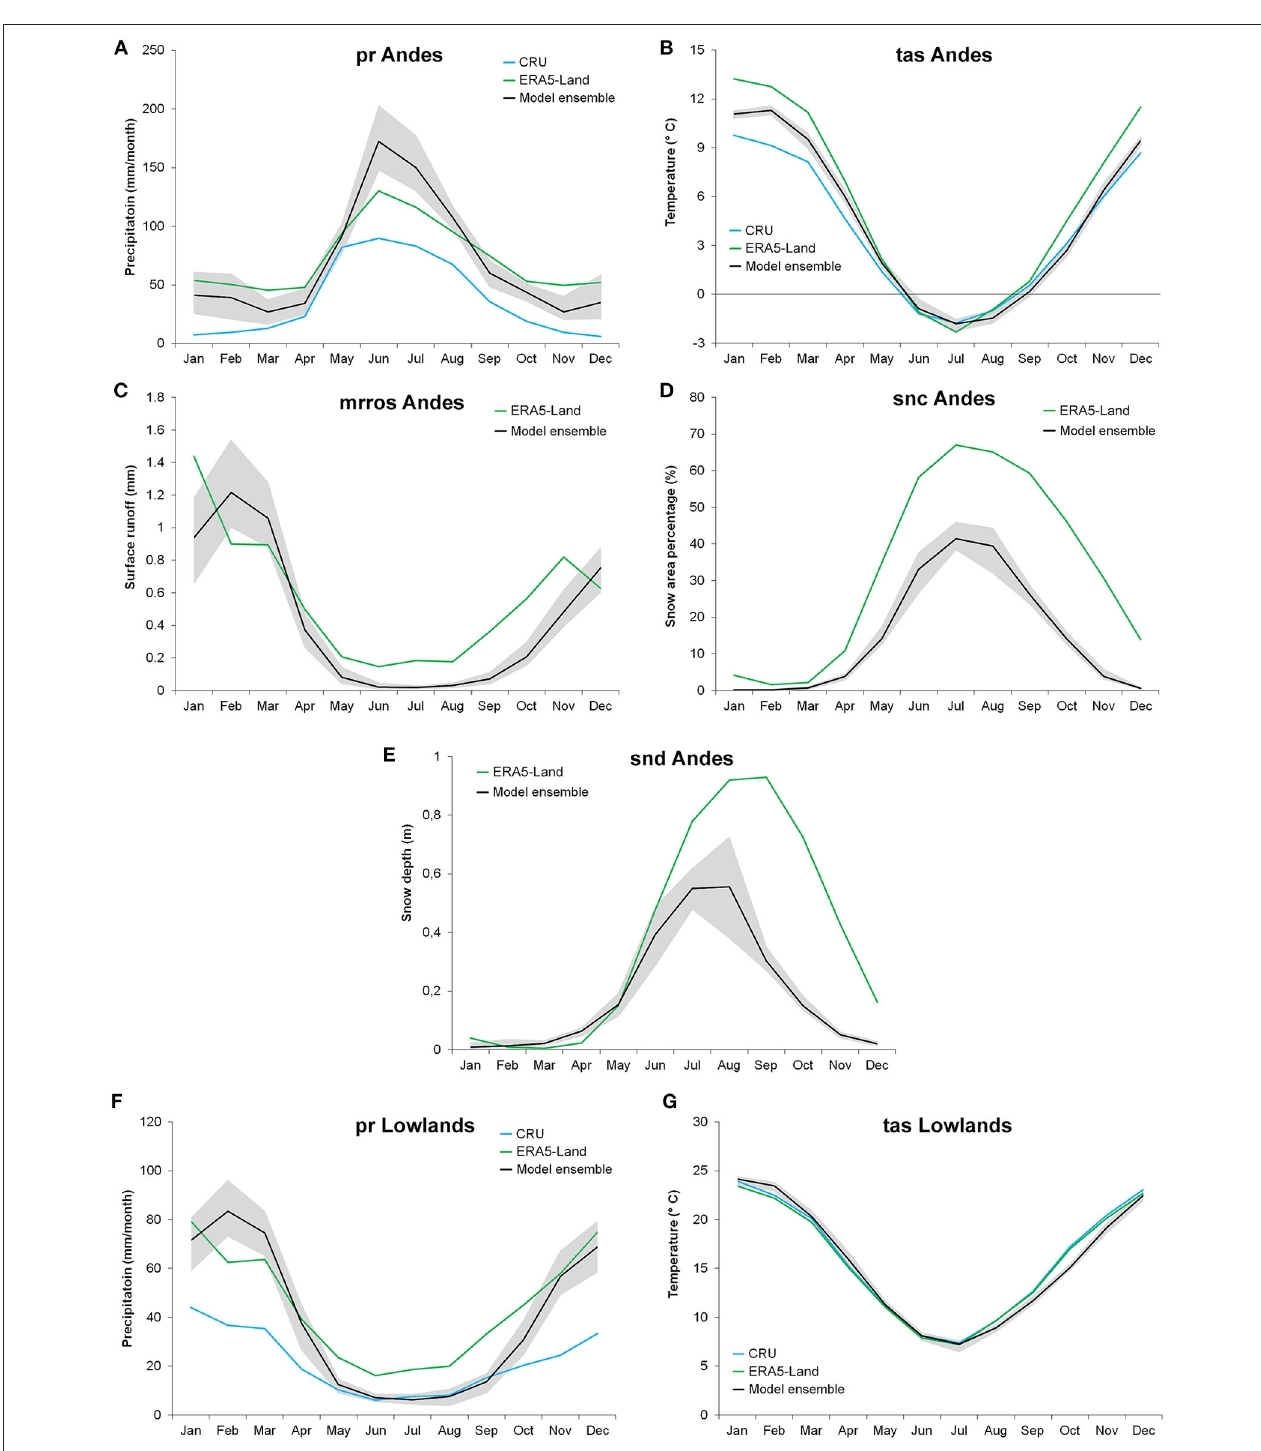
FIGURE 2 | Annual cycle of the variables considered for the validation of the IPSL-CM6A-LR model runs over the 1981–2010 control period. (A–E) Show the annual cycle over the Andes domain, while (F,G) show the annual cycle over the Lowlands. The black lines represent the model ensemble mean considering the 10 historical runs selected, the blue lines represent the annual cycle obtained through the CRU TS 4.04 database, the green lines show the variables obtained through ERA5-Land reanalysis. The gray shading indicates the 5 and 95% quantiles derived from the dispersion of the historical runs. (A) pr (mm), (B) tas ( ◦ C), (C) mrros (the depth in mm the water would have if it were spread evenly over the grid box), (D) snc (the fraction of the cell in % occupied by snow), (E) snd (m), (F) pr (mm), and (G) tas ( ◦ C).